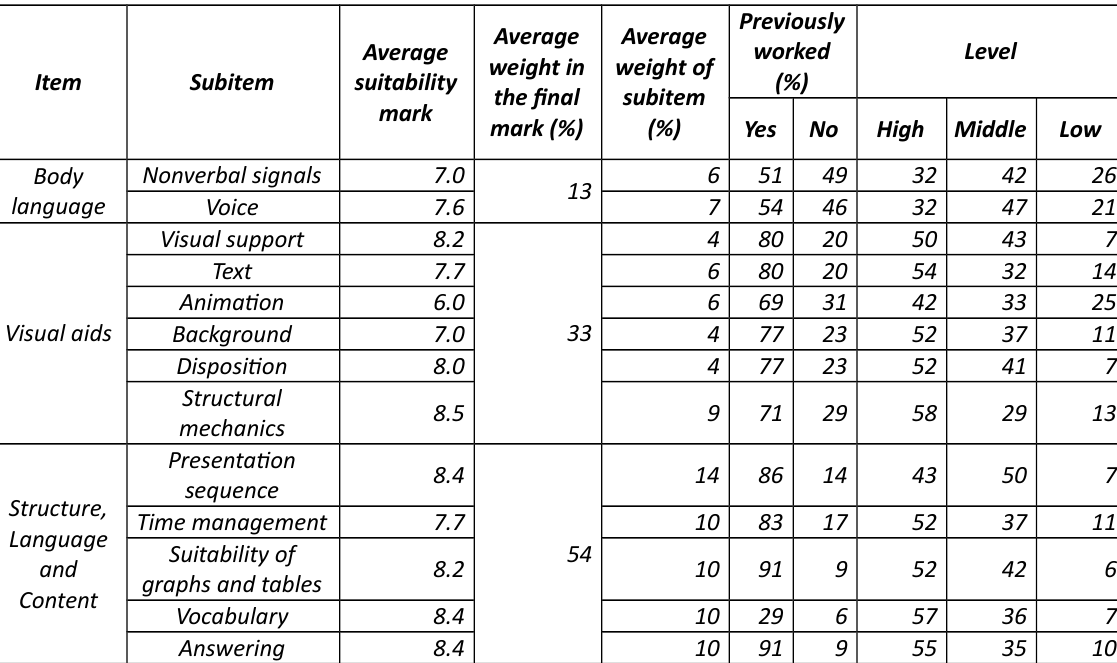
Table 4. Analysis of the results of the validaton of the rubric for oral communicaton